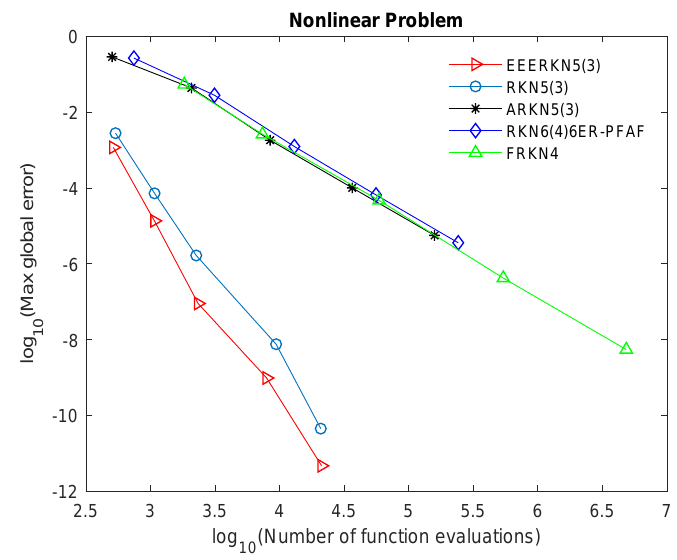
Figure 4. Efficiency curves for Problem